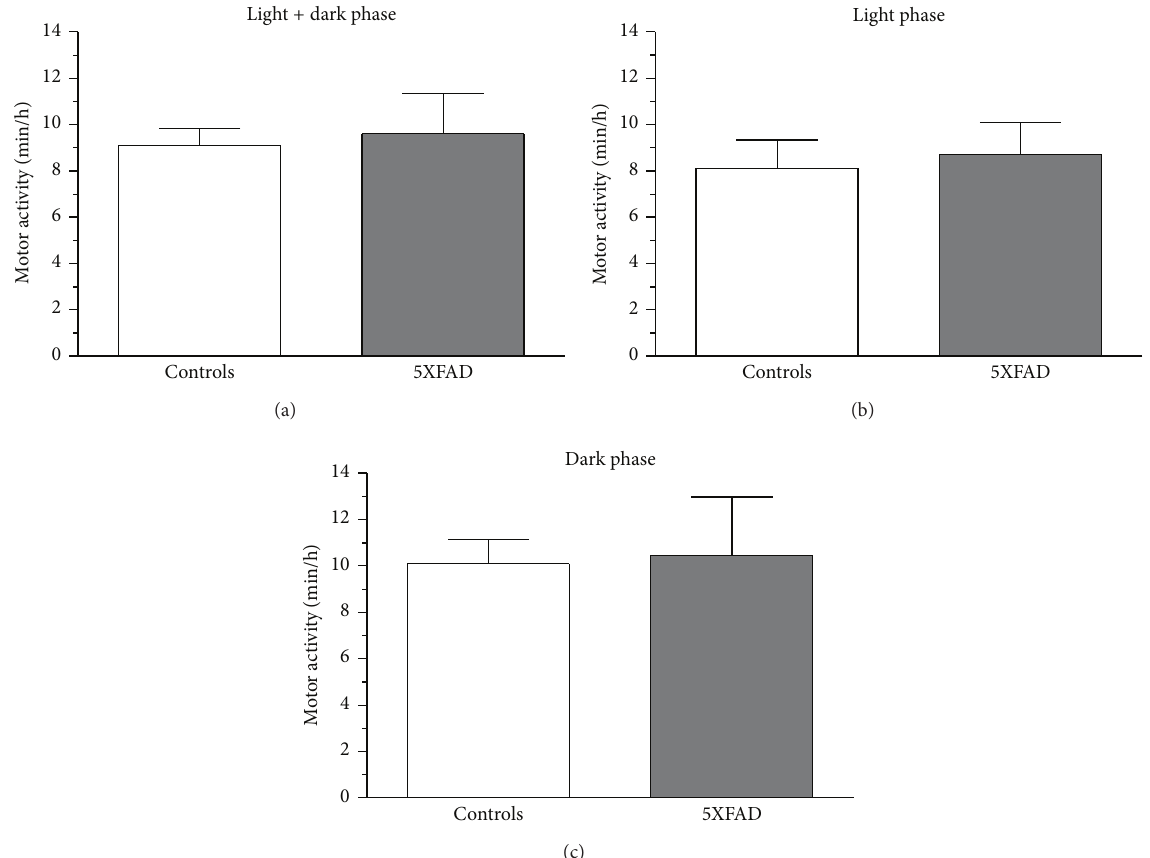
Figure 5: Motor activity in controls and 5XFAD mice. The radiotelemetry system is capable of measuring movement in the horizontal plane as relative units. 10s epochs were categorized in a binary fashion as motor segments or nonmotor segments. Motor activity was then calculated as (min/h) for the whole observation period (light + dark phase, (a)) and the light (b) and dark phases (c) separately. No difference was observed between both